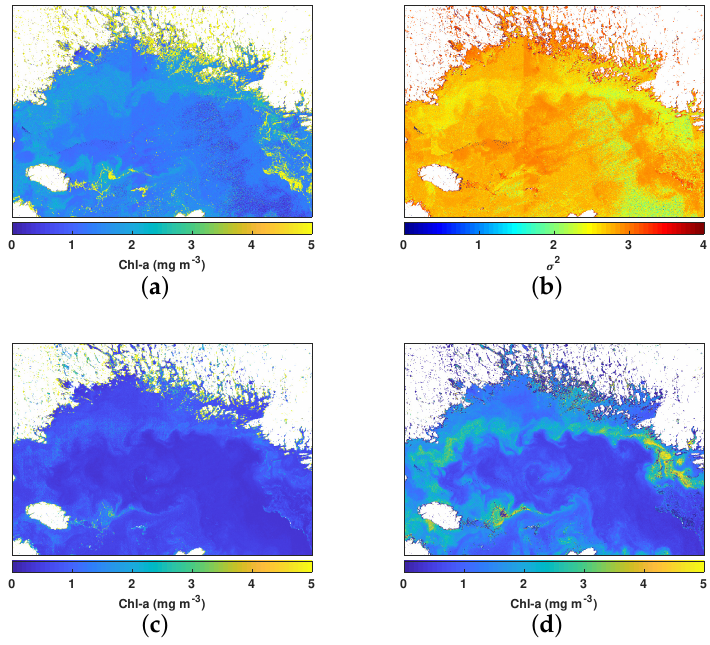
Figure A3. Estimated Chl-a in the Marginal Ice Zone for the enlarged area: ML GPR Balaton model ( a ) and corresponding certainty map ( b ), NN ( c ) and OC4 ( d ). The unit of Chl-a is mg m − 3